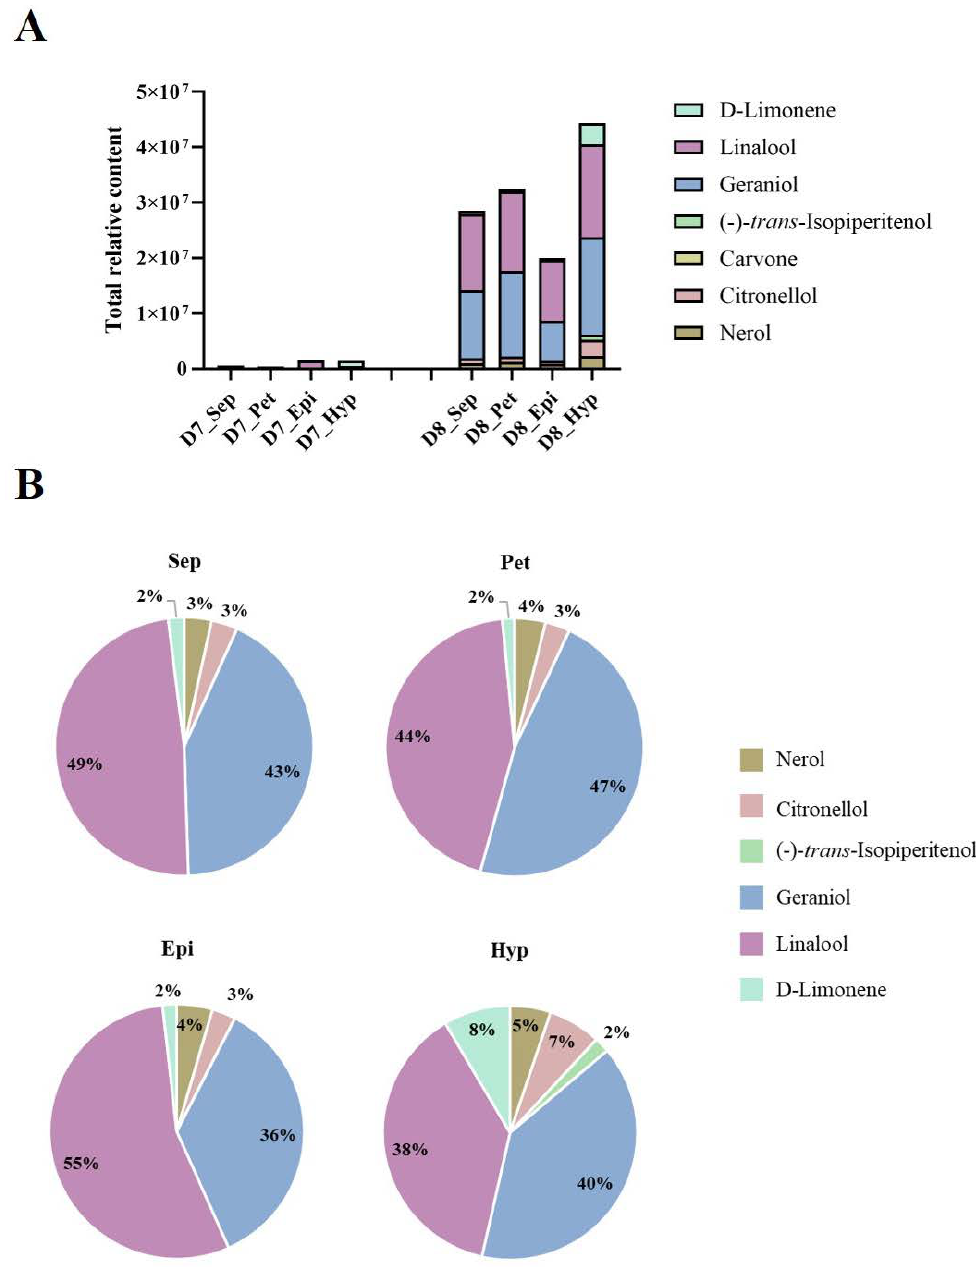
Figure 3. The types and relative contents of monoterpenes in four parts of the KOVA flower at stages D7 and D8. ( A ) The total relative contents of the monoterpenes in each part of the flower at D7 and D8. The four parts of KOVA flowers at D7 and D8 were sampled and analyzed using headspace GC–MS. The sepal, petal, epichile, and hypochile are abbreviated as Sep, Pet, Epi, and Hyp, respectively. The relative content represents the result calculated by the external standard method based on data produced by GC. The total relative content represents the sum total of all monoterpene relative contents. The data are the mean ± SD from three biological replicates. ( B ) The proportion of the relative contents of each monoterpene in the total relative content in different parts of the KOVA flower at D8.